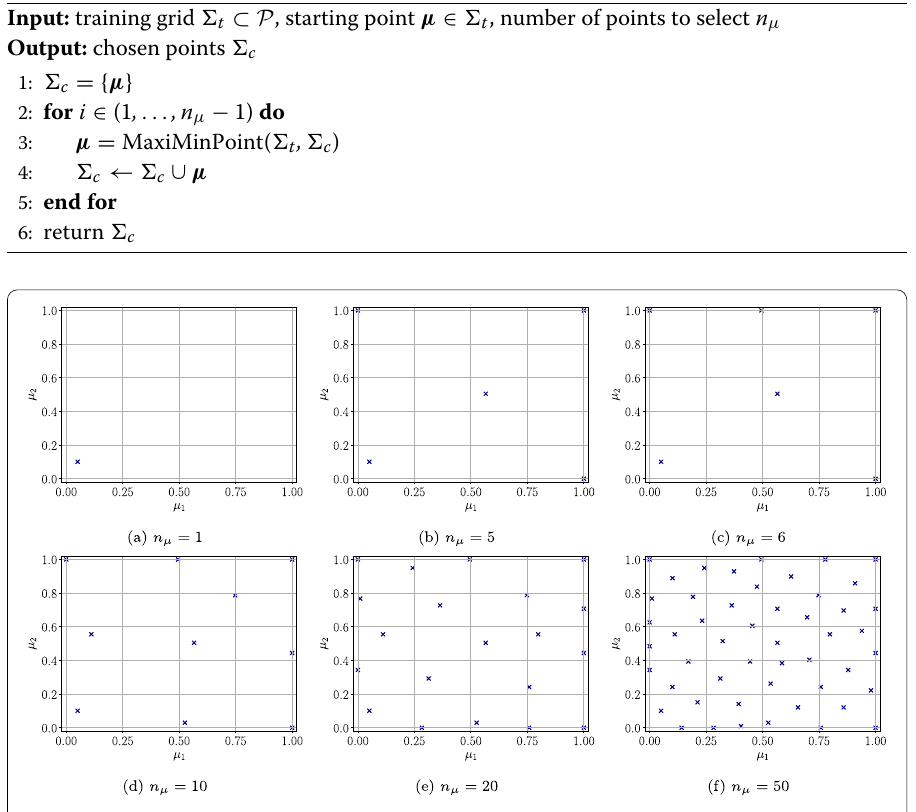
Fig. 2 Greedy MMD design for a 2D parameter space with n μ points. The first point is chosen at random